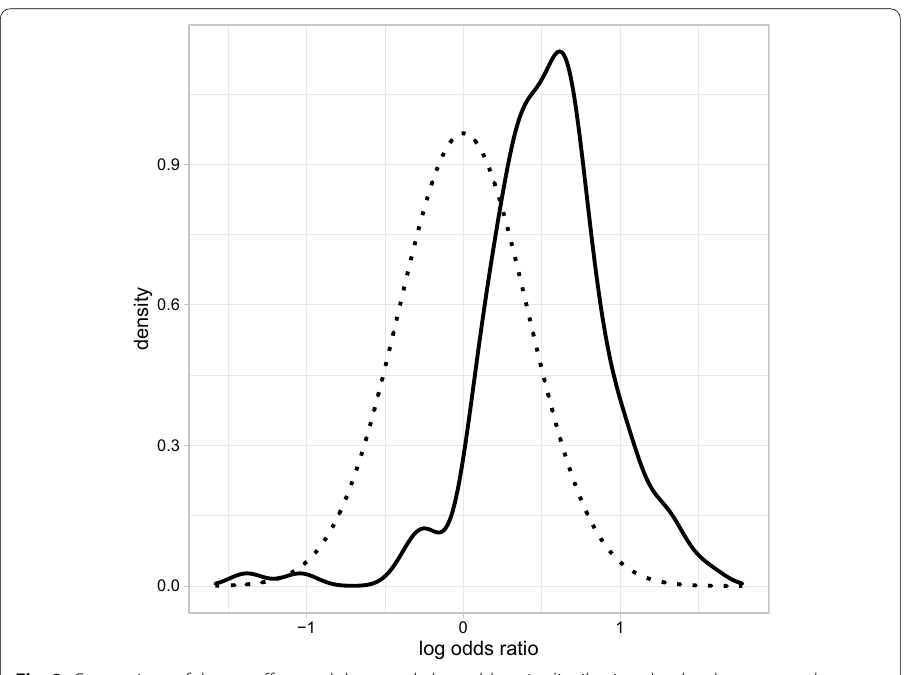
Fig. 2 Comparison of the no‑effect and the sample log odds ratio distributions by development and controlled for language (full sample, dotted = =